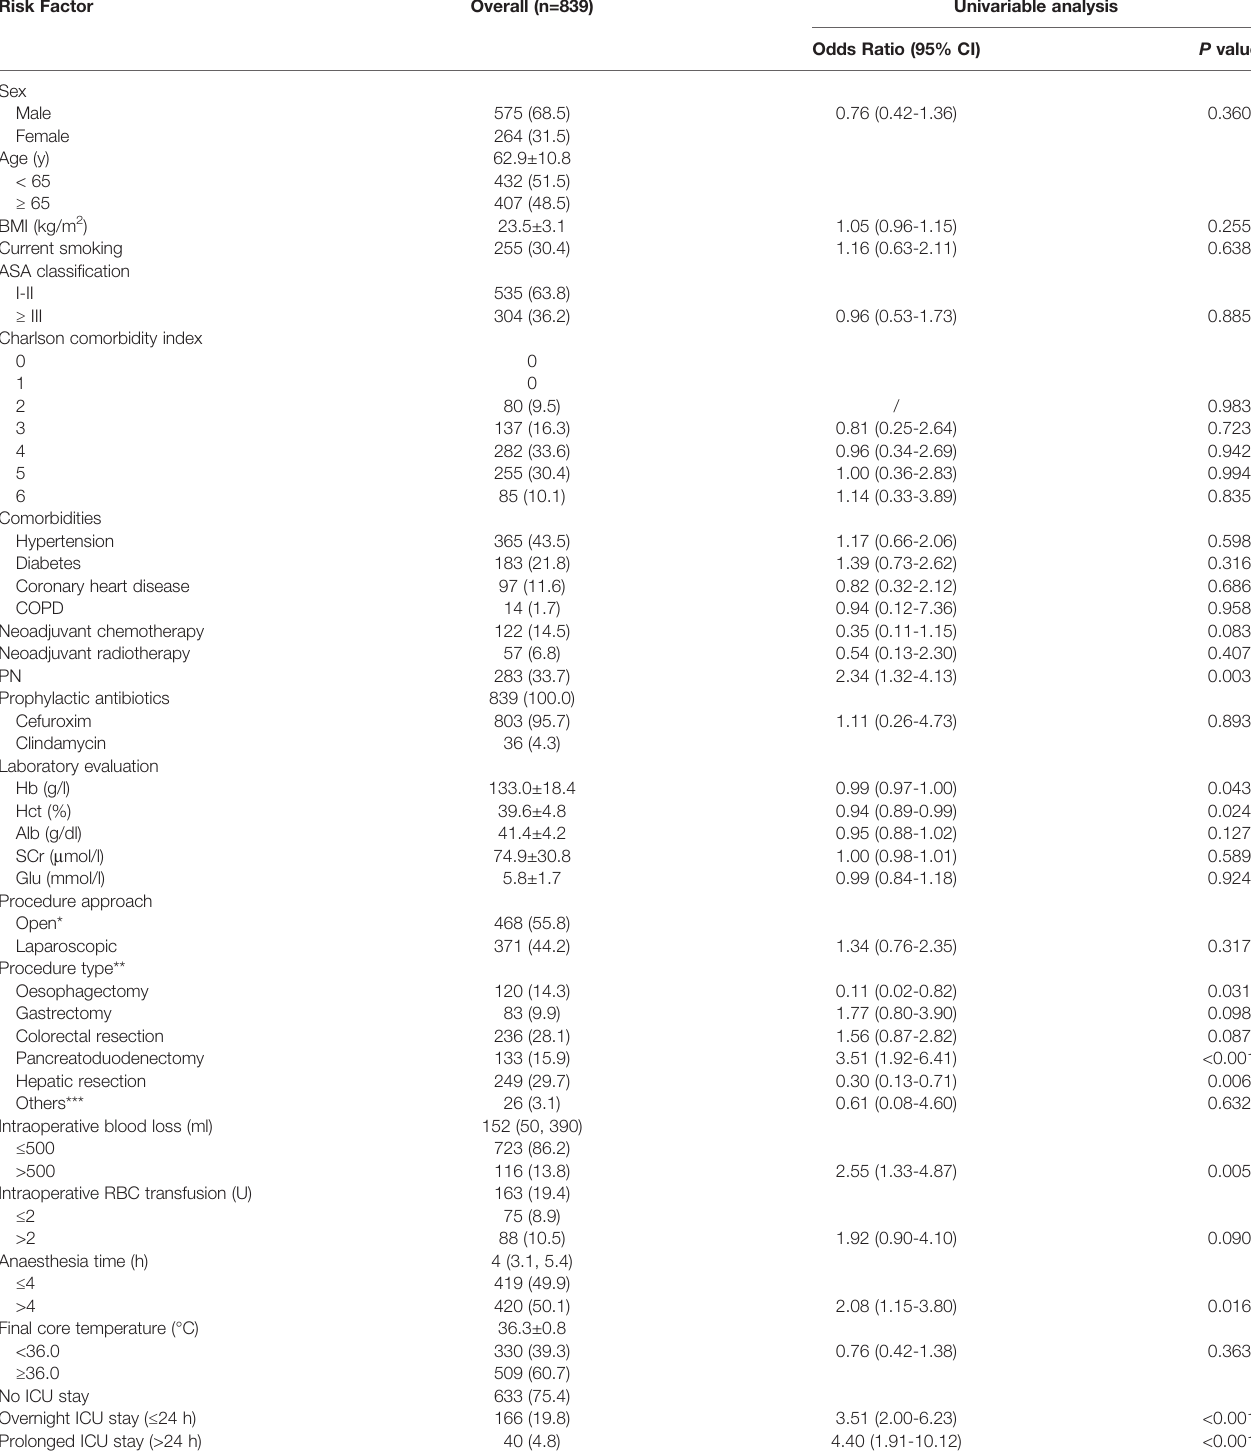
TABLE 1 | Baseline characteristics and risk factors for organ/space surgical site infection (Univariable Analysis) in advanced digestive system